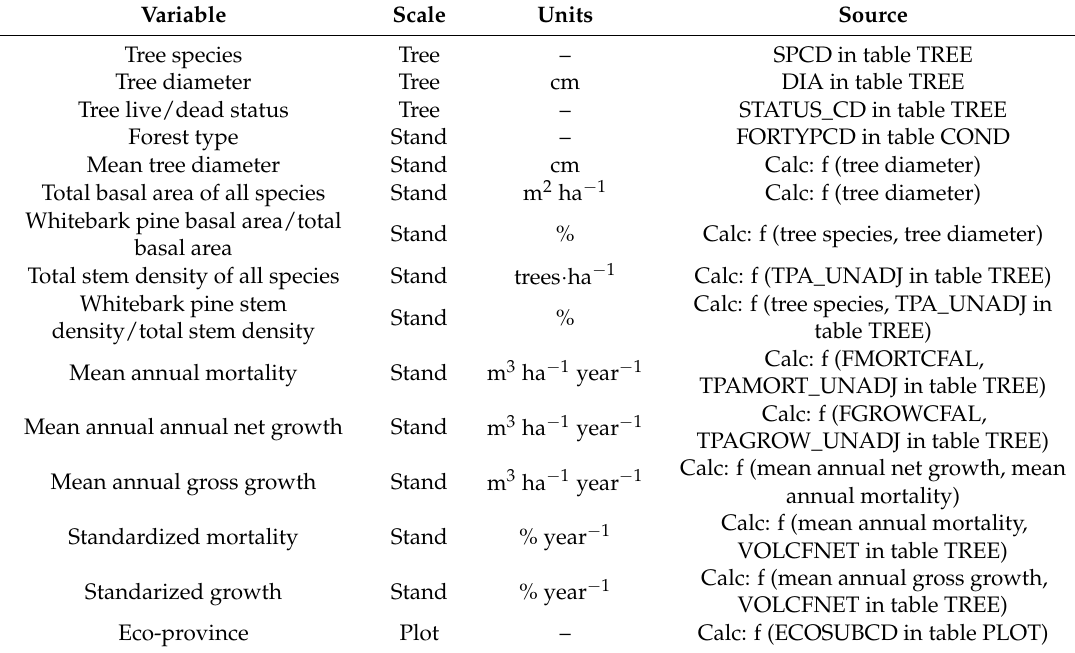
Table 1. Summary of variables used in this study, including scale (tree, stand, or plot level), units, and source.